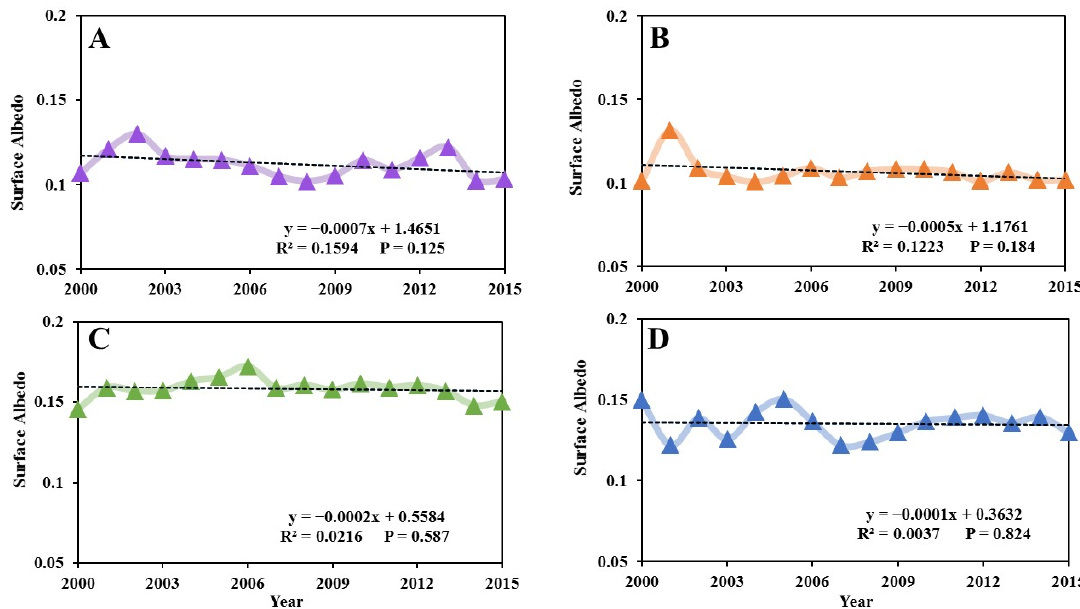
Figure 8. Trend of surface albedo from 2000 to 2015 (( A ) Jinan City, ( B ) Zhengzhou City, ( C ) Lanzhou City, ( D ) Xining City).